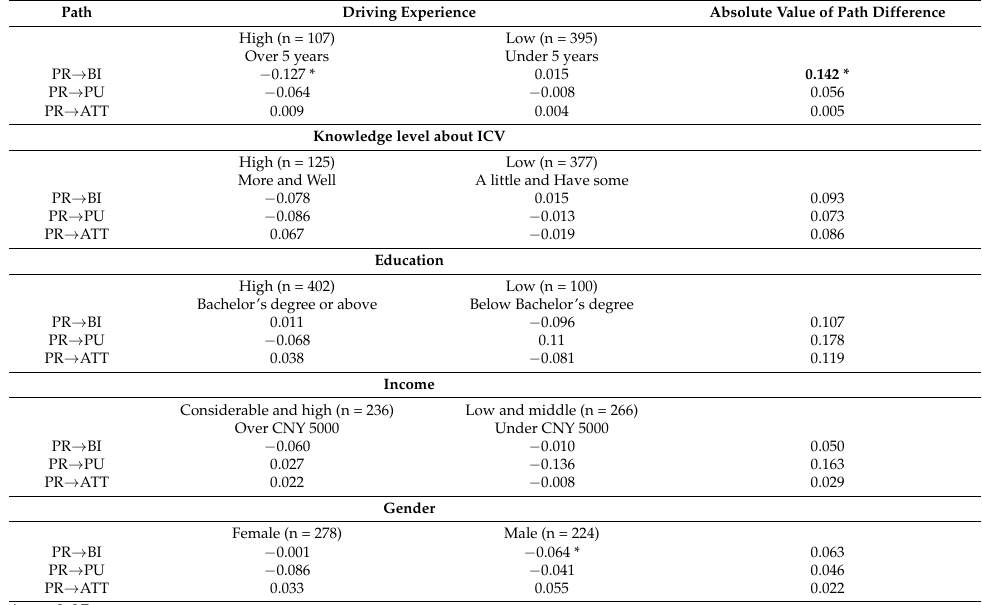
Table 8. Moderating effects